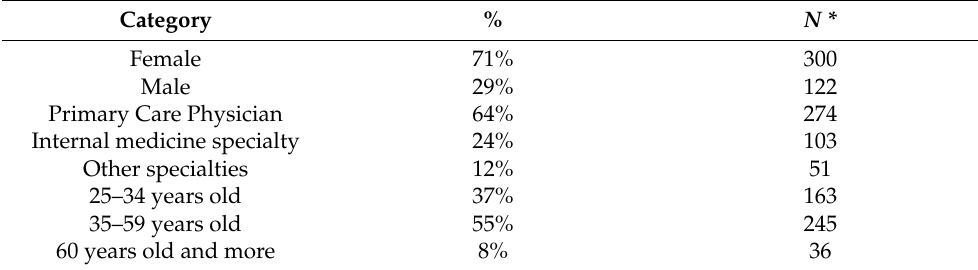
Table 1. Main characteristics of the